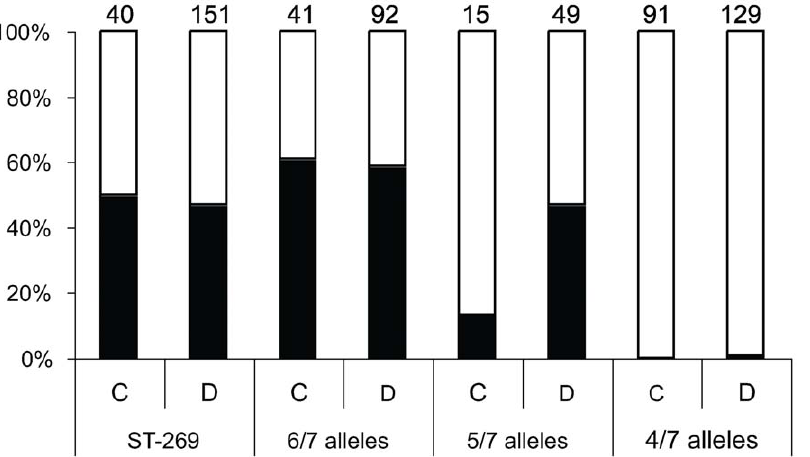
Figure 5. Presence of IS 1301 in the IGR of carriage isolates and disease isolates. Carriage (C) and disease (D) isolates were analysed for the presence of IS 1301 in the IGR depending on the numbers of loci the STs share with ST-269. Black bars represent strains with IS 1301 in the IGR and white bars show the frequency of isolates without IS 1301 in the IGR. Numbers above bars indicate the total number of isolates.